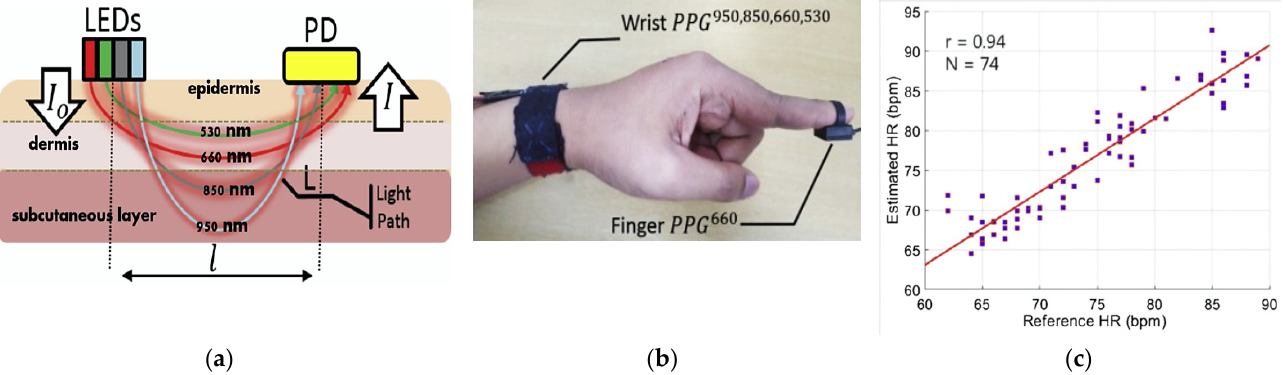
Figure 9. PPG-based device used for the measurement of multiple optical wavelengths; ( a ) sensor structure, ( b ) the biosensor placed on the wrist of the submissive, a commercial PPG placed on the finger, ( c ) correlation diagram of the estimated heart rate from the proposed structure with the commercial device [35] (Reprinted with permission from ref. [35]. Copyright 2021 Elsevier).